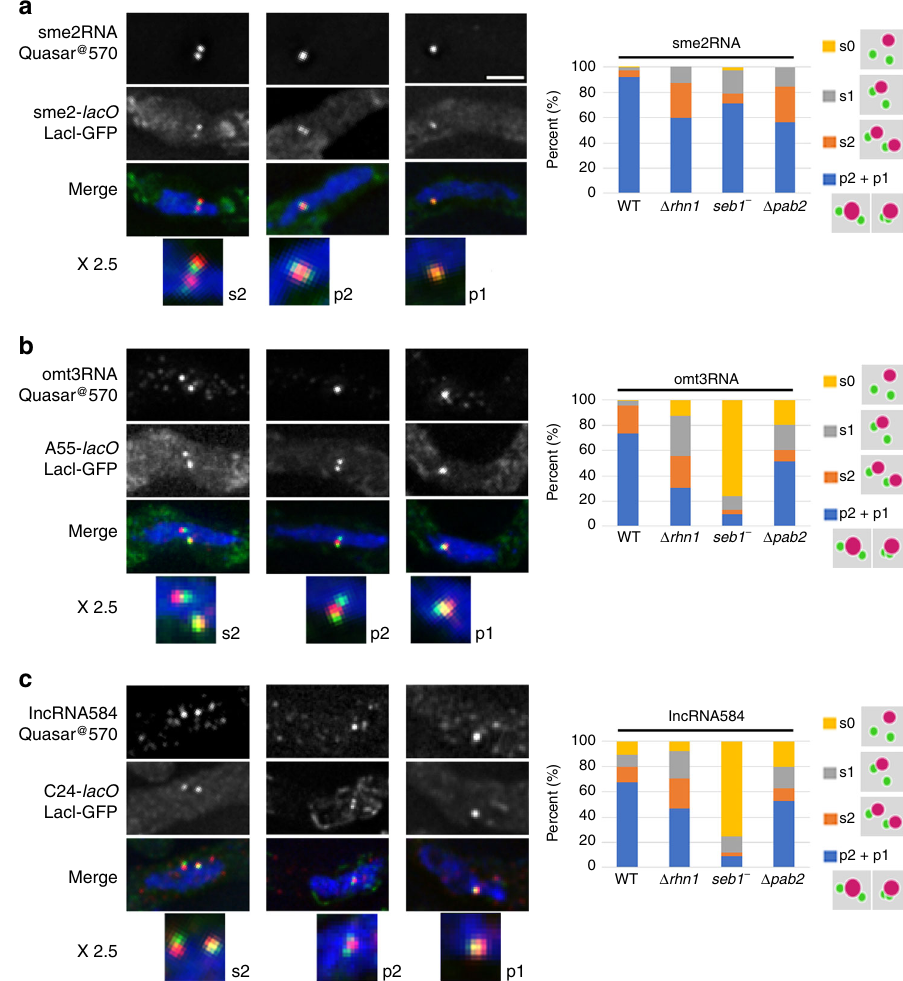
Fig. 3 Localization of lncRNA on homologous chromosome loci. (Left) smFISH analysis for sme2 RNA ( a ), omt3 RNA ( b ), and lncRNA584 ( c ) using sequence-speci fi c probes labeled with Quasar ® 570. Chromosomal loci were visualized using lacO /LacI-GFP. DNA was visualized using 4 ′ ,6-diamidino-2- phenylindole. In the merged images, smFISH is shown in red, lacO /LacI-GFP in green, and DNA in blue. Enlarged images (×2.5) are shown at the bottom. The abbreviations are as follows: s2: two separate RNA dots, each associated with a LacI-GFP dot, p2: a single RNA dot between two juxtaposed LacI-GFP dots, and p1: a single RNA dot with a paired LacI-GFP dot. Scale bar, 2 μ m. (Right) Signal patterns of smFISH counted ( n > 100 for each sample) in WT, rhn1 deletion mutant ( Δ rhn1 ), seb1-E38 mutant ( seb1 − ), and pab2 deletion ( Δ pab2 ) mutant. p2 and p1 (blue) and s2 (orange) are de fi ned above. s1 (gray): two separate LacI-GFP dots, only one of which is associated with an RNA dot. s0 (yellow): two separate LacI-GFP dots, none of which is associated with an RNA dot. Source data for Fig. 3 are provided as a Source Data fi le